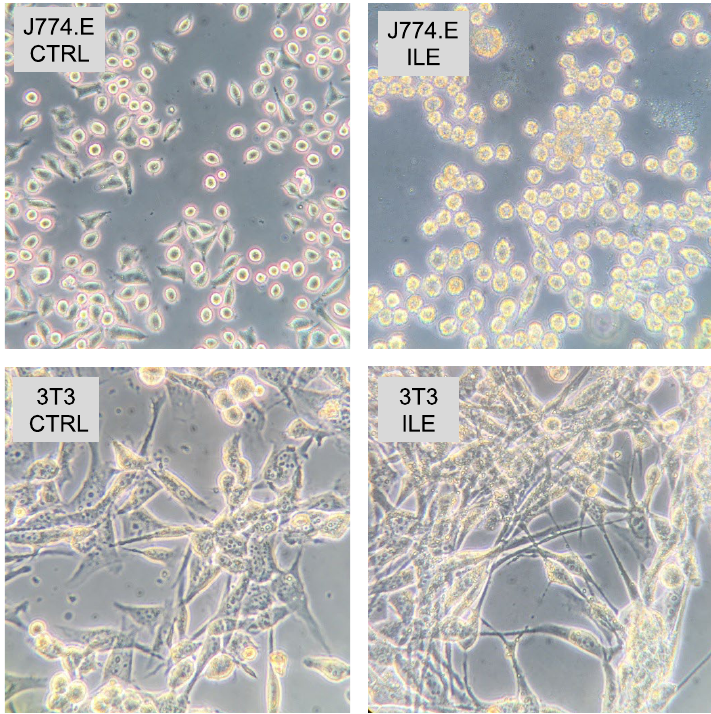
Figure 2. J774.E and 3T3 cell lines after the exposure to Intralipid (8%) (ILE), in comparison to the cells cultured in standard conditions (CTRL).